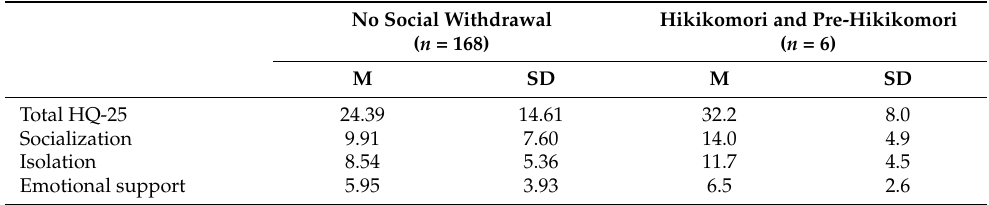
Table 5. Descriptive statistics for the HQ-25 according to lifetime history of hikikomori and pre-hikikomori.